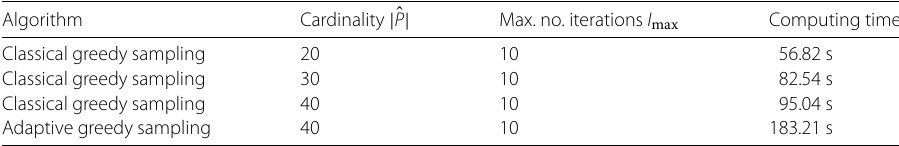
Table 4 Computing time/reduction time ( T Q ) to generate projection subspace